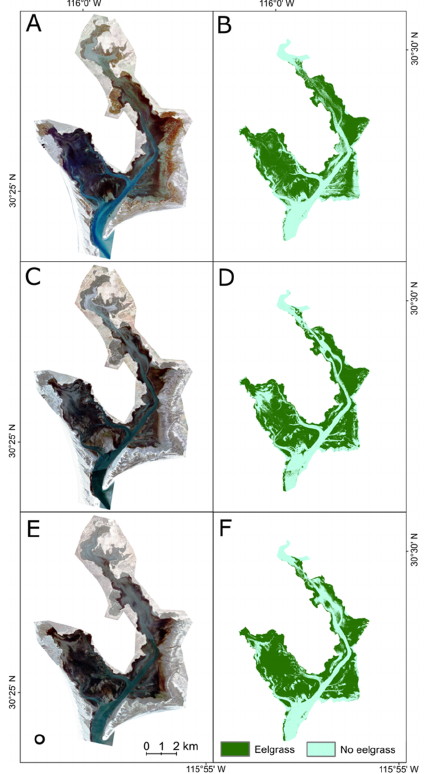
Figure 2. Multispectral satellite imagery (PlanetScope) and SVM classification outputs for January ( A , B ), March ( C , D ) and October ( E , F ) in 2019, respectively. Panels ( B , D , F ) show Eelgrass and No eelgrass classes only, excluding the area classified as salt marsh or upland.